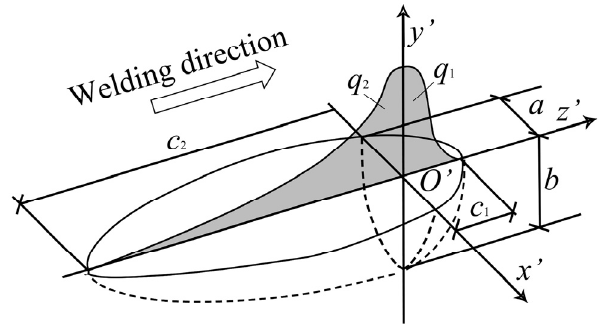
Figure 9. Double ellipsoidal heat source model.